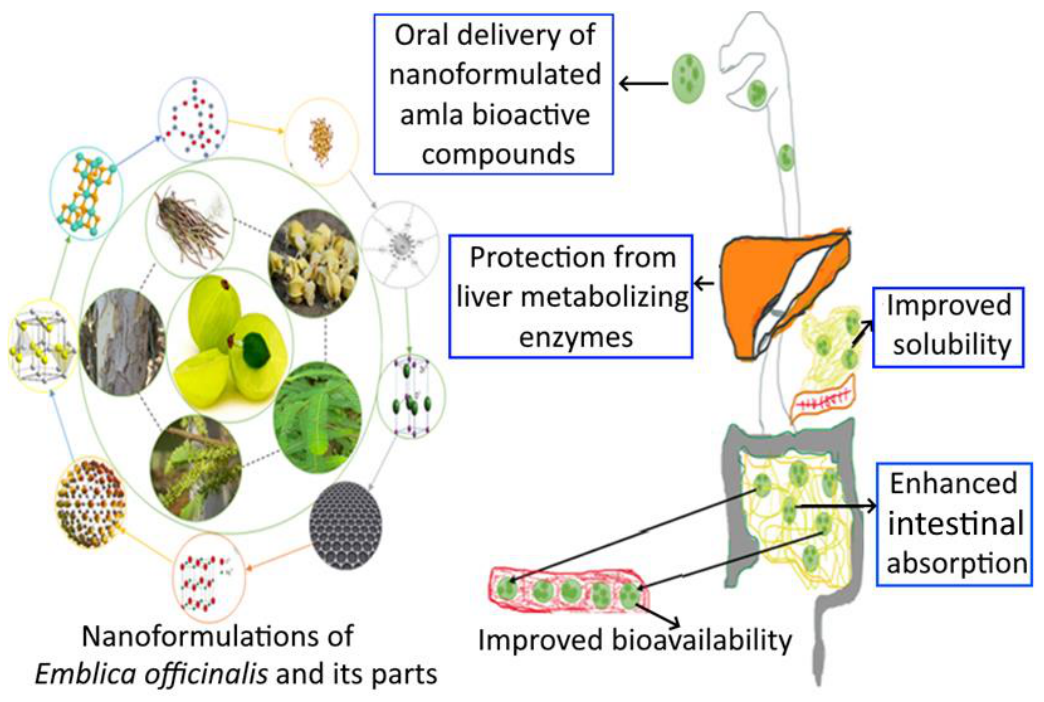
Figure 5. Nanoformulations of amla and its health